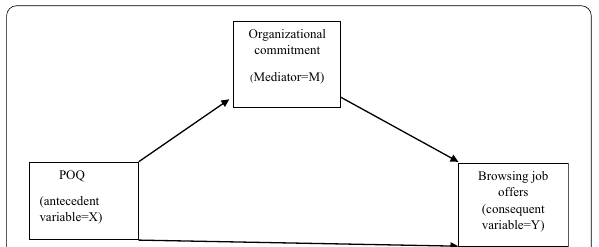
Fig. 2 Conceptual model for the mechanism through which POQ affects browsing job offers in the press and the Internet (hypotheses